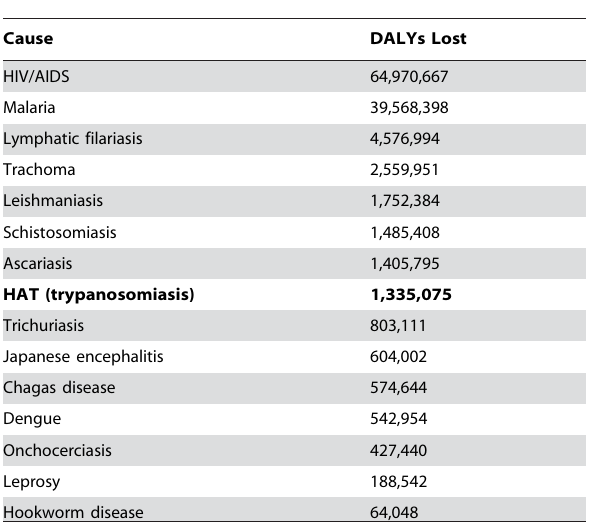
Table 1. Selected DALYs Lost by Cause,